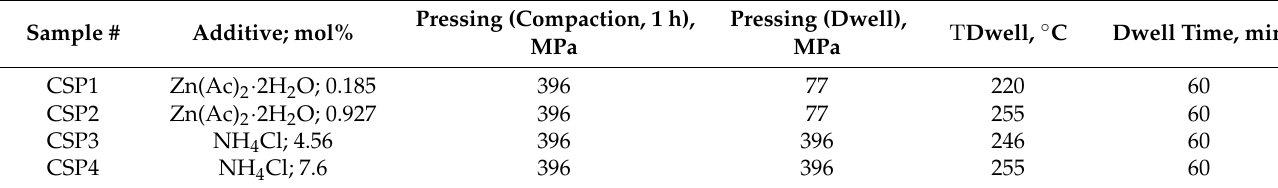
Figure 1. The CSP setup: 1—coil induction heater; 2—thermocouple; 3—hydraulic press; 4—die mold; 5—set of punches; 6—ZnO powder; 7—seal rings; 8—motion sensor; 9—Power Supply. Table 2. The CSP conditions. Table 2. The CSP conditions.